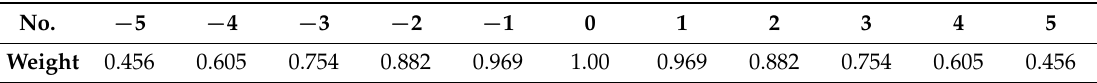
Table 1. Weights assignment of 11